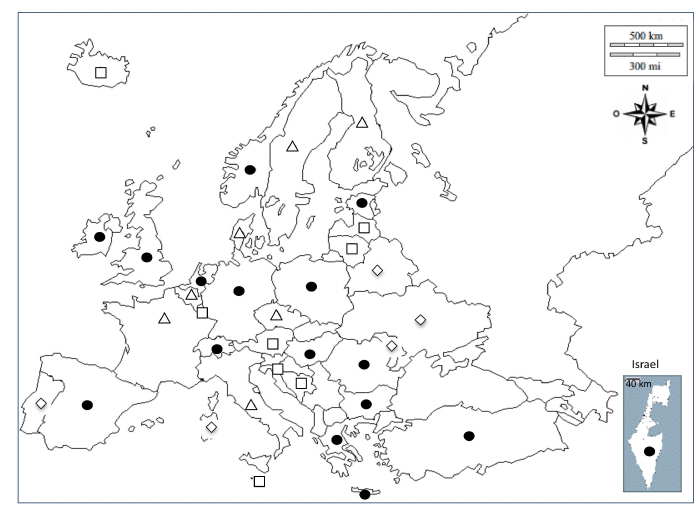
Figure 1. We highlight the, (i) commitments to formalized ERIs in National roadmaps (open triangle), (ii) presence of a National roadmap indicating commitment to one of more ERI (filled circle), (iii) absence of a National roadmap and/or piecemeal involvement in ERI (open square), and (iv) none of the above (open rhombus). This is a result of all 22 national roadmaps